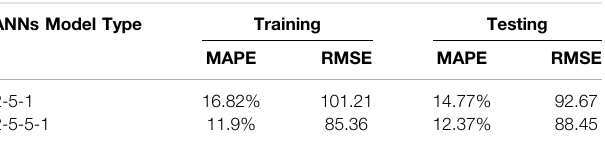
TABLE 3 | ANNs model results.